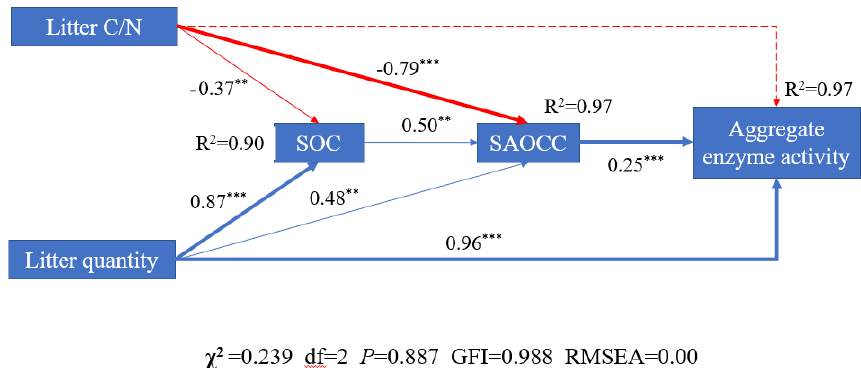
Figure 6. Structural equation model revealing the direct and indirect effects of litter C/N, litter quantity, soil organic carbon and soil aggregate organic C content (SAOCC) on aggregate enzyme activity. **: p < 0.01, ***: p < 0.001. Arrows represent the directional influence of one variable upon another. The numbers adjacent to the arrows are standardized path coefficients. Blue and red arrows indicate positive and negative correlations, respectively. Continuous and dashed arrows indicate significant and insignificant relationships, respectively. SAOCC: soil aggregate organic C content, Litter C/N: carbon and nitrogen ratio of litter, SOC: soil organic carbon.